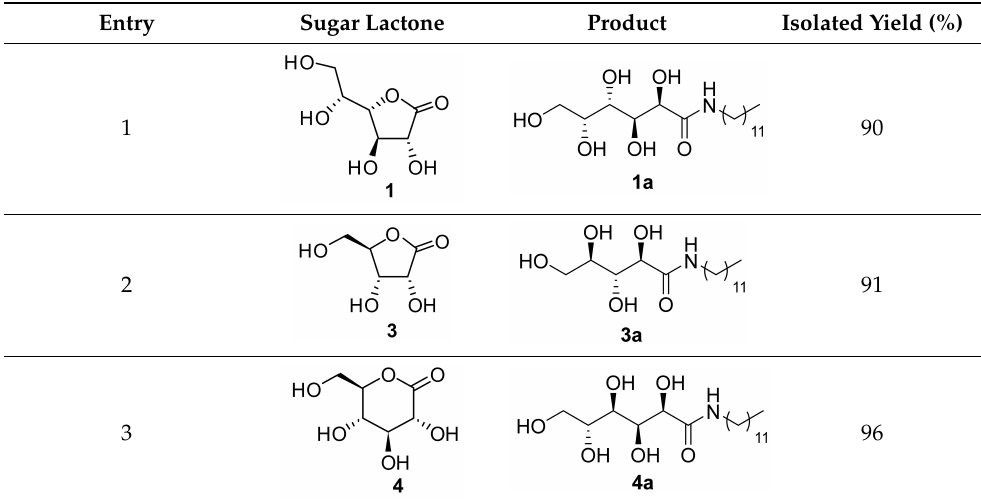
Table 3. Applications to various sugar lactones a .